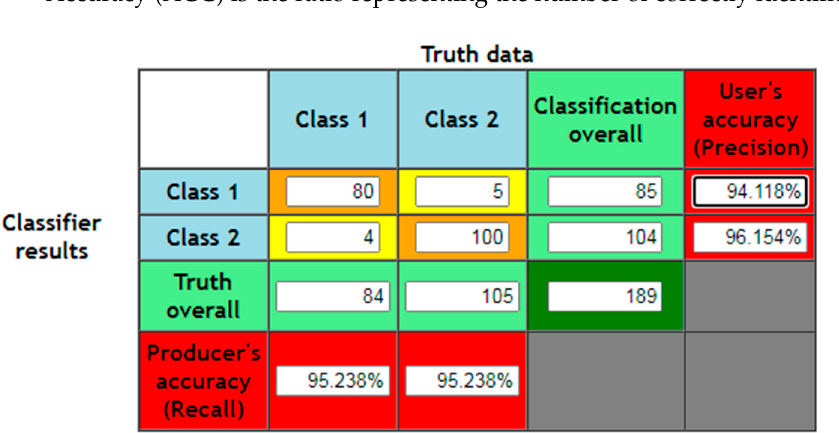
Figure 12. Confusion matrix of the proposed HSAS-MD.